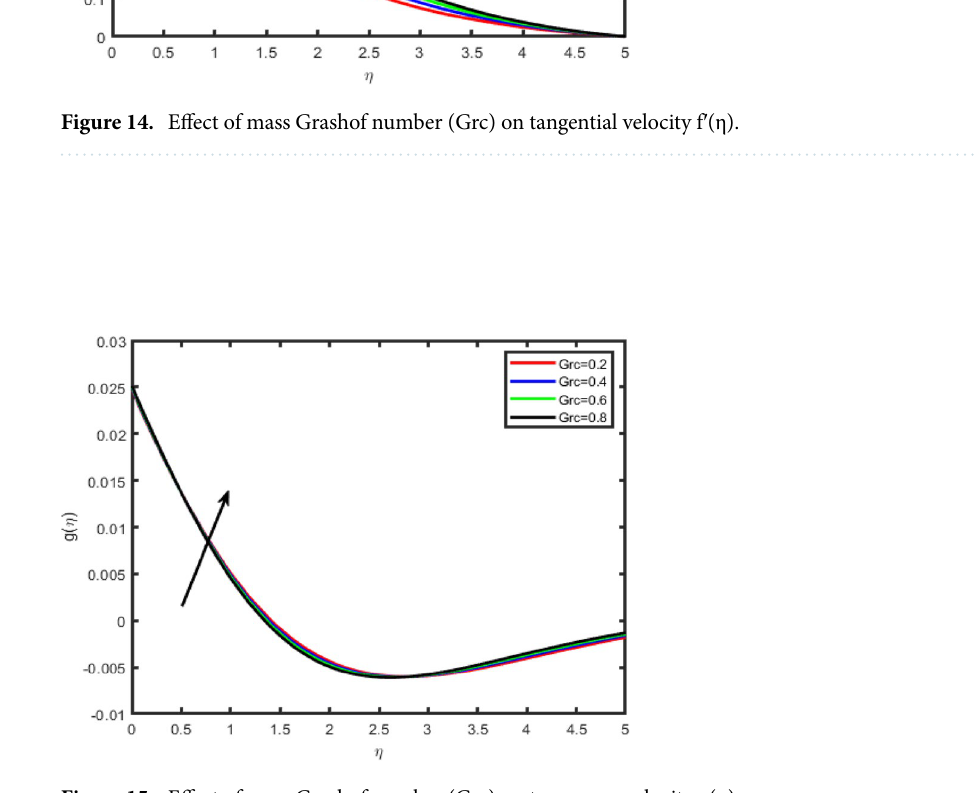
Figure 15. Effect of mass Grashof number (Grc) on transverse velocity